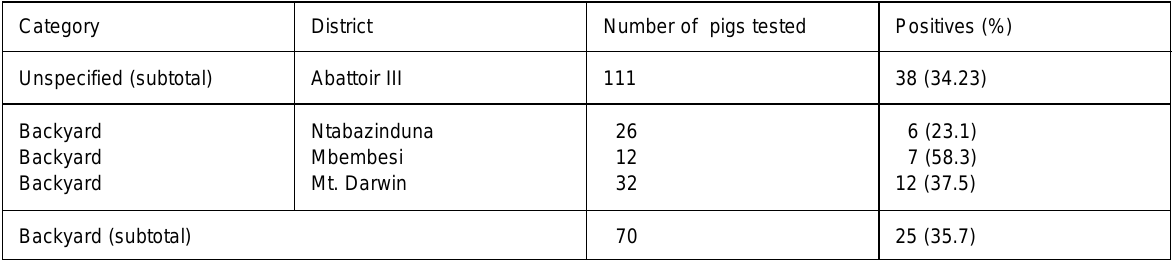
TABLE 3 Prevalence of Toxoplasma gondii IgG IFAT antibodies in pigs from abattoir III and from backyard herds